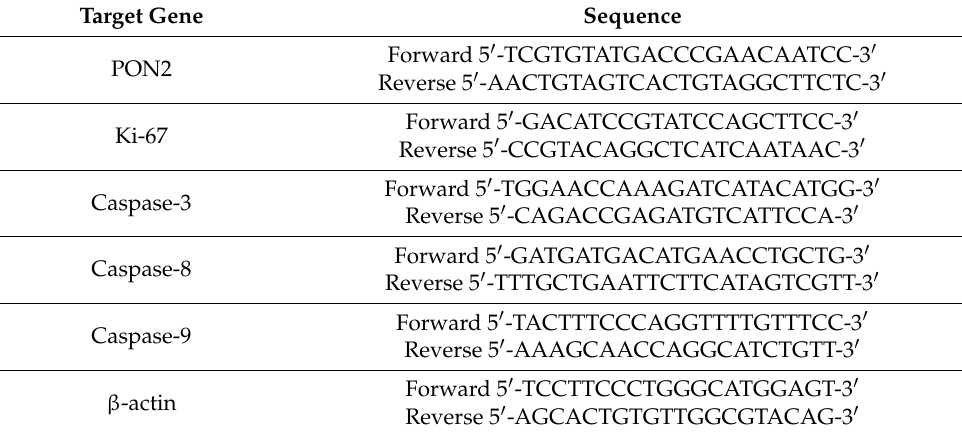
Table 1. Primers used for quantitative Real-Time PCR. Target